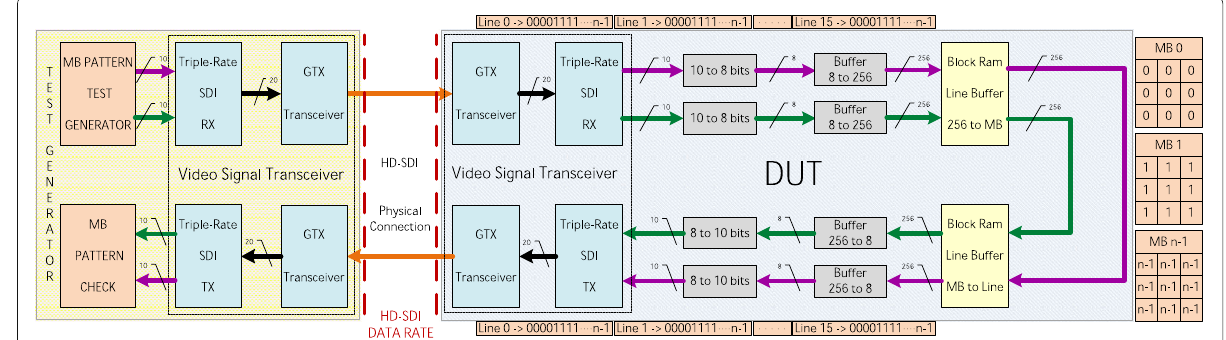
Fig. 4 Test-bench applied to a real case: the experiment validation model is ported on a Virtex-6 Xilinx